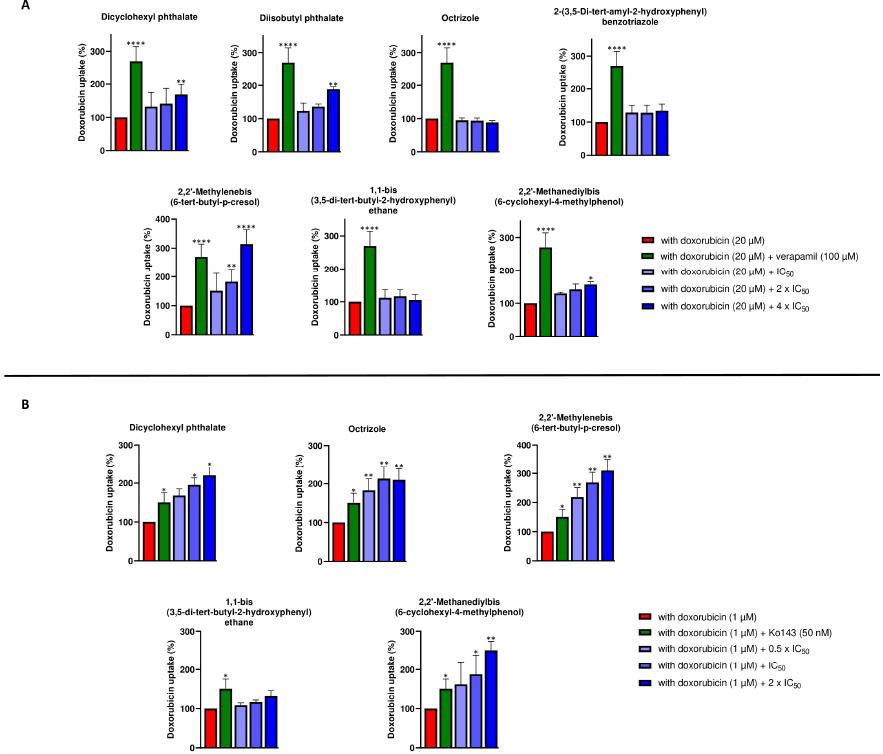
Figure 5. P-gp and BCRP uptake assay. ( A ) Quantification of fluorescence intensity as bar diagram on CEM/ADR5000-overexpressed P-gp cells. Experiments were performed in three replicates and are depicted as mean ± SD. (* p < 0.05, ** p < 0.01, **** p < 0.0001, compared to doxorubicin-treated cells). CEM/ADR5000 cells treated with doxorubicin (red) and doxorubicin in combination with three different concentrations (IC 50 , 2 × IC 50 , 4 × IC 50 ) for seven selected compounds (scale of blue). Cells treated with doxorubicin in combination with verapamil, a known P-gp inhibitor, which was used as positive control (green). ( B ) Quantification of fluorescence intensity as bar diagram on MDA-MB-231-BCRP-overexpressed BCRP cells. Experiments were performed in three replicates and are depicted as mean ± SD. (* p < 0.05, ** p < 0.01, compared to doxorubicin-treated cells). Cells treated with doxorubicin (red) and doxorubicin in combination with three different concentrations (0.5 × IC 50 , IC 50 , 2 × IC 50 ) for five selected compounds (scale of blue). Cells treated with doxorubicin in combination with Ko143, a known BCRP inhibitor, which was used as positive control (green).